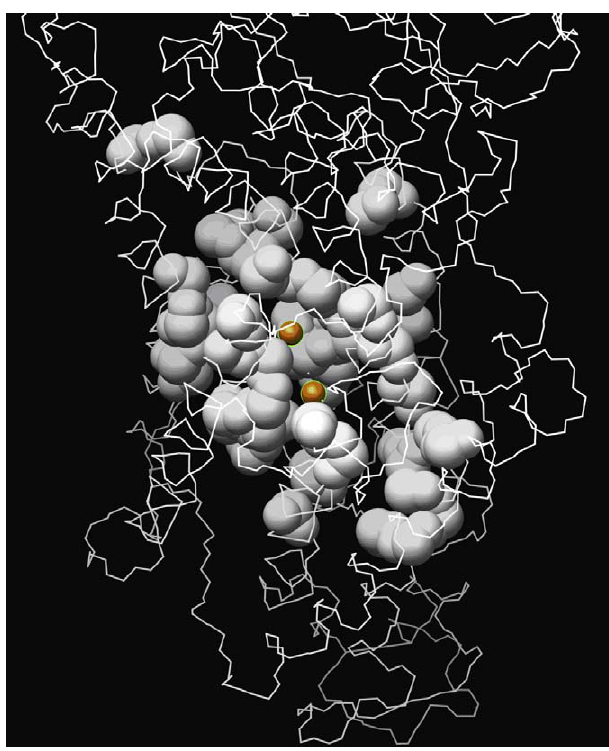
Figure 2. Comparison of the Predicted SERCA Ligand Binding Site (White Spheres) and the Two Calcium Ions (Orange Spheres)